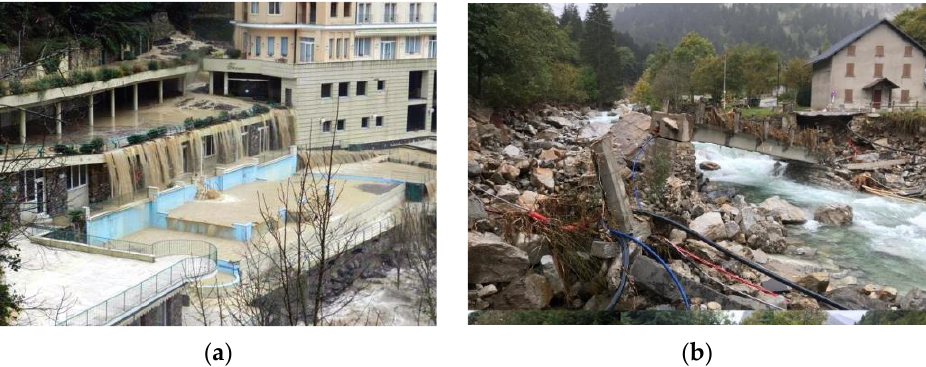
Figure 2. Effects of floods associated to intense sediment transport on thermal facilities close to Bagni di Vinadio (fewer than 60 km away) for recent events: ( a ) Terme di Pigna [42], 2014 event and ( b ) Terme di Valdieri (photo by the authors during surveys for the severe event occurring in October 2020).